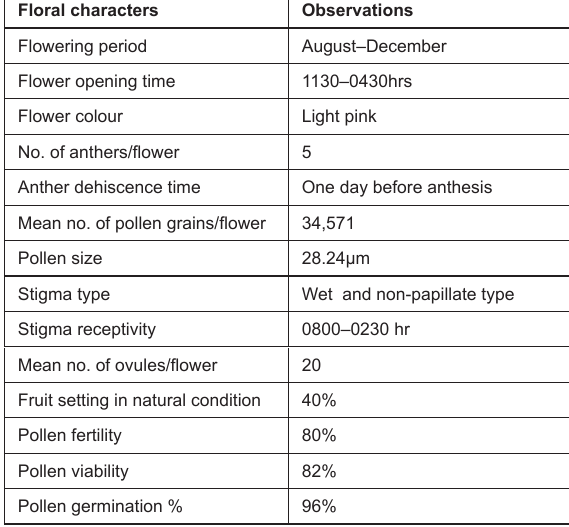
Table 1. Floral biology of Impatiens